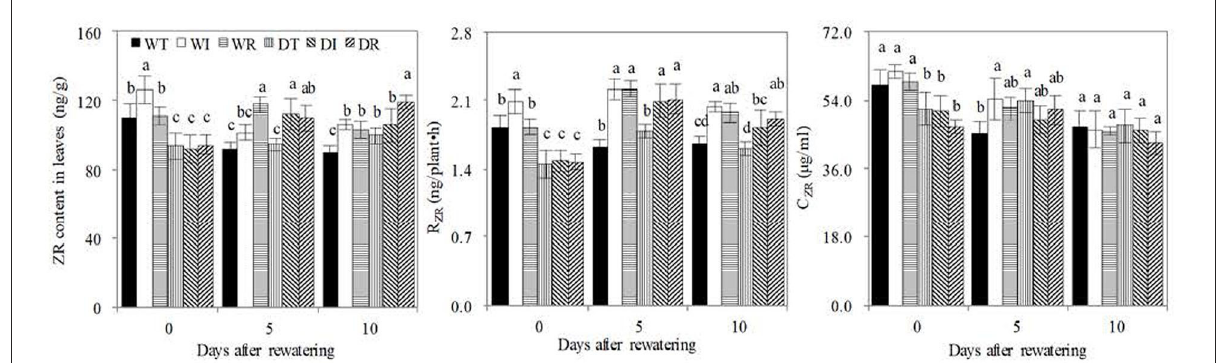
FIGURE6 ZR, RZR, and CZR concentrations in the newly grown leaves. WT, WI, WR, DT, DI, and DR indicate treatments of wetness, wetness with AOB strain inoculation during wet period, wetness with AOB strain inoculation during rewatering period, post-drought rewatering, post-drought rewatering with AOB strain inoculation during wet period, post-drought rewatering with AOB strain inoculation during rewatering period, respectively. In “0”, “5”, and “10” respectively stand for the beginning, 5th day, 10th day of the 10-day rewatering period. CZR mean ZR concentrations in xylem sap. RZR mean delivery rates of ZR from roots to leaves, respectively. The values are the mean ± standard error ( n = 3). The different letters in each row indicate significant differences ( P < 0.05).